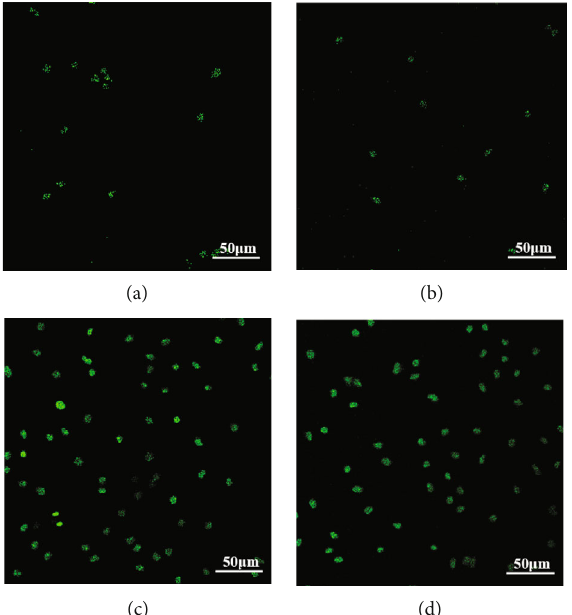
Figure 3: CAL-27 cell proliferation assessment after chemotherapy. (a) Ki67 expression pattern in CAL-27 cells without treatment. (b) Ki67 expression pattern in CAL-27 cells in H-ULK1 group. (c) Ki67 expression pattern in CAL-27 cells in L-ULK1 group. (d) Ki67 expression pattern in CAL-27 cells in L-ULK1/H-miR-214 group.